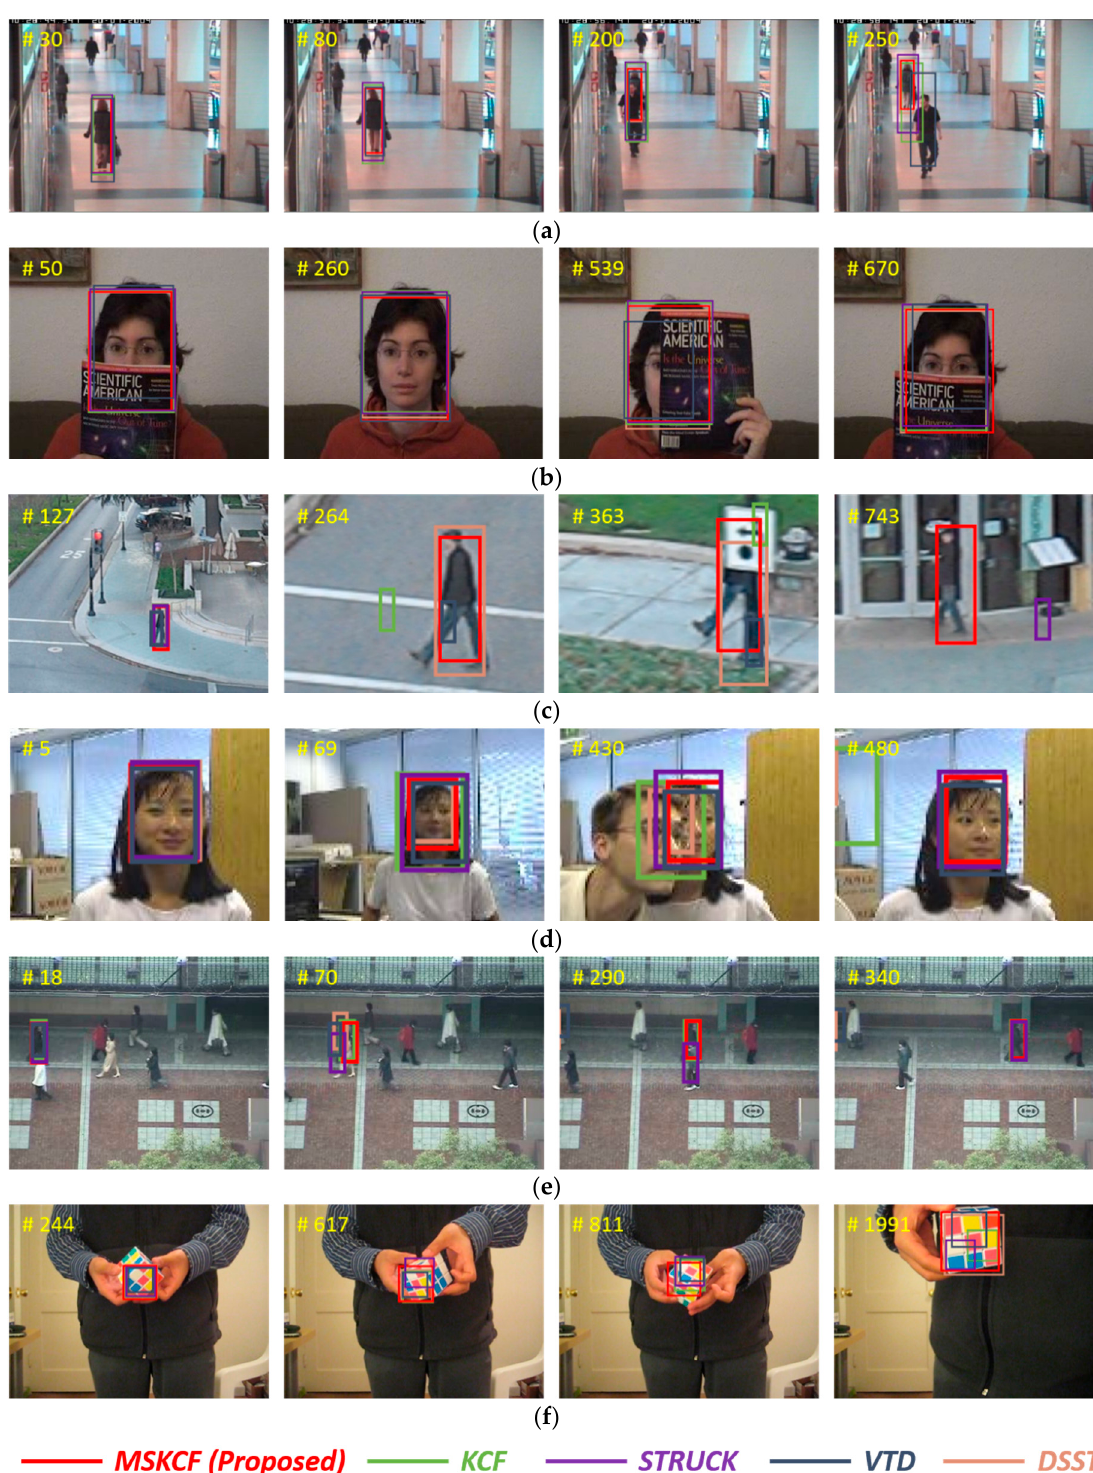
Figure 7. Tracking results under scale variations. ( a ) Singer1; ( b ) Surfer; ( c ) Dog1; and ( d ) Human4.